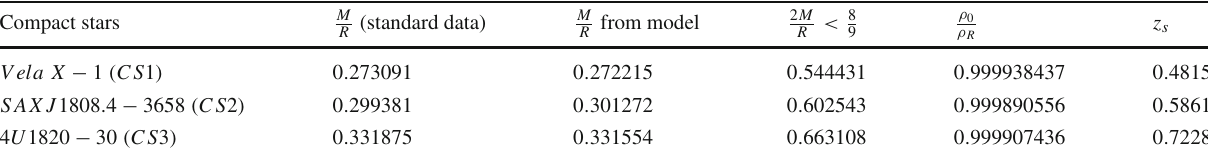
Table 9 Calculated values of the desired parameters of our model from Table 3 Compact stars M